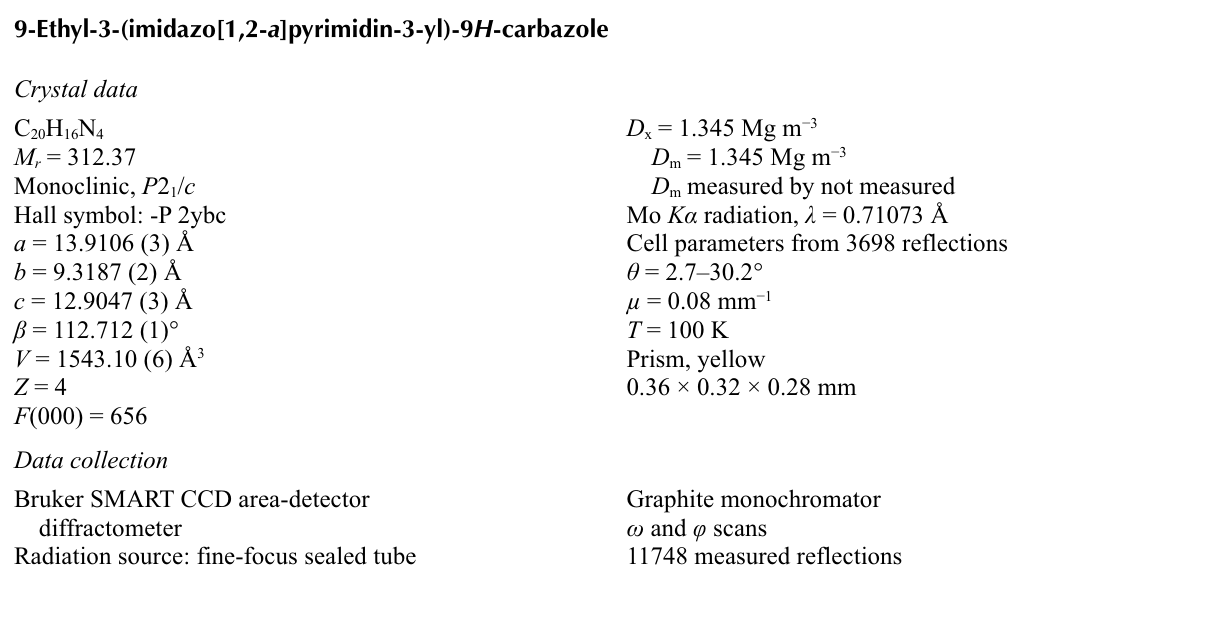
The formation of the title